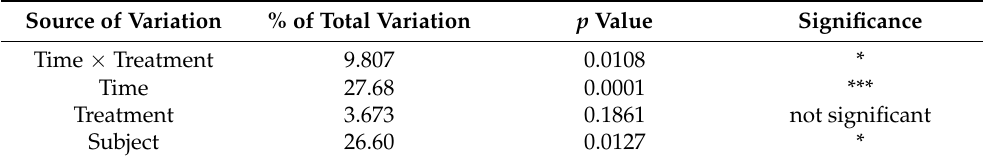
Figure 1. Normalized levels of the neutralizing antibody in both booster and placebo groups over time. Table 4. Two-way ANOVA with Tukey’s post hoc test results for the data of participants’ normalized neutralization antibody levels at different times (before and after